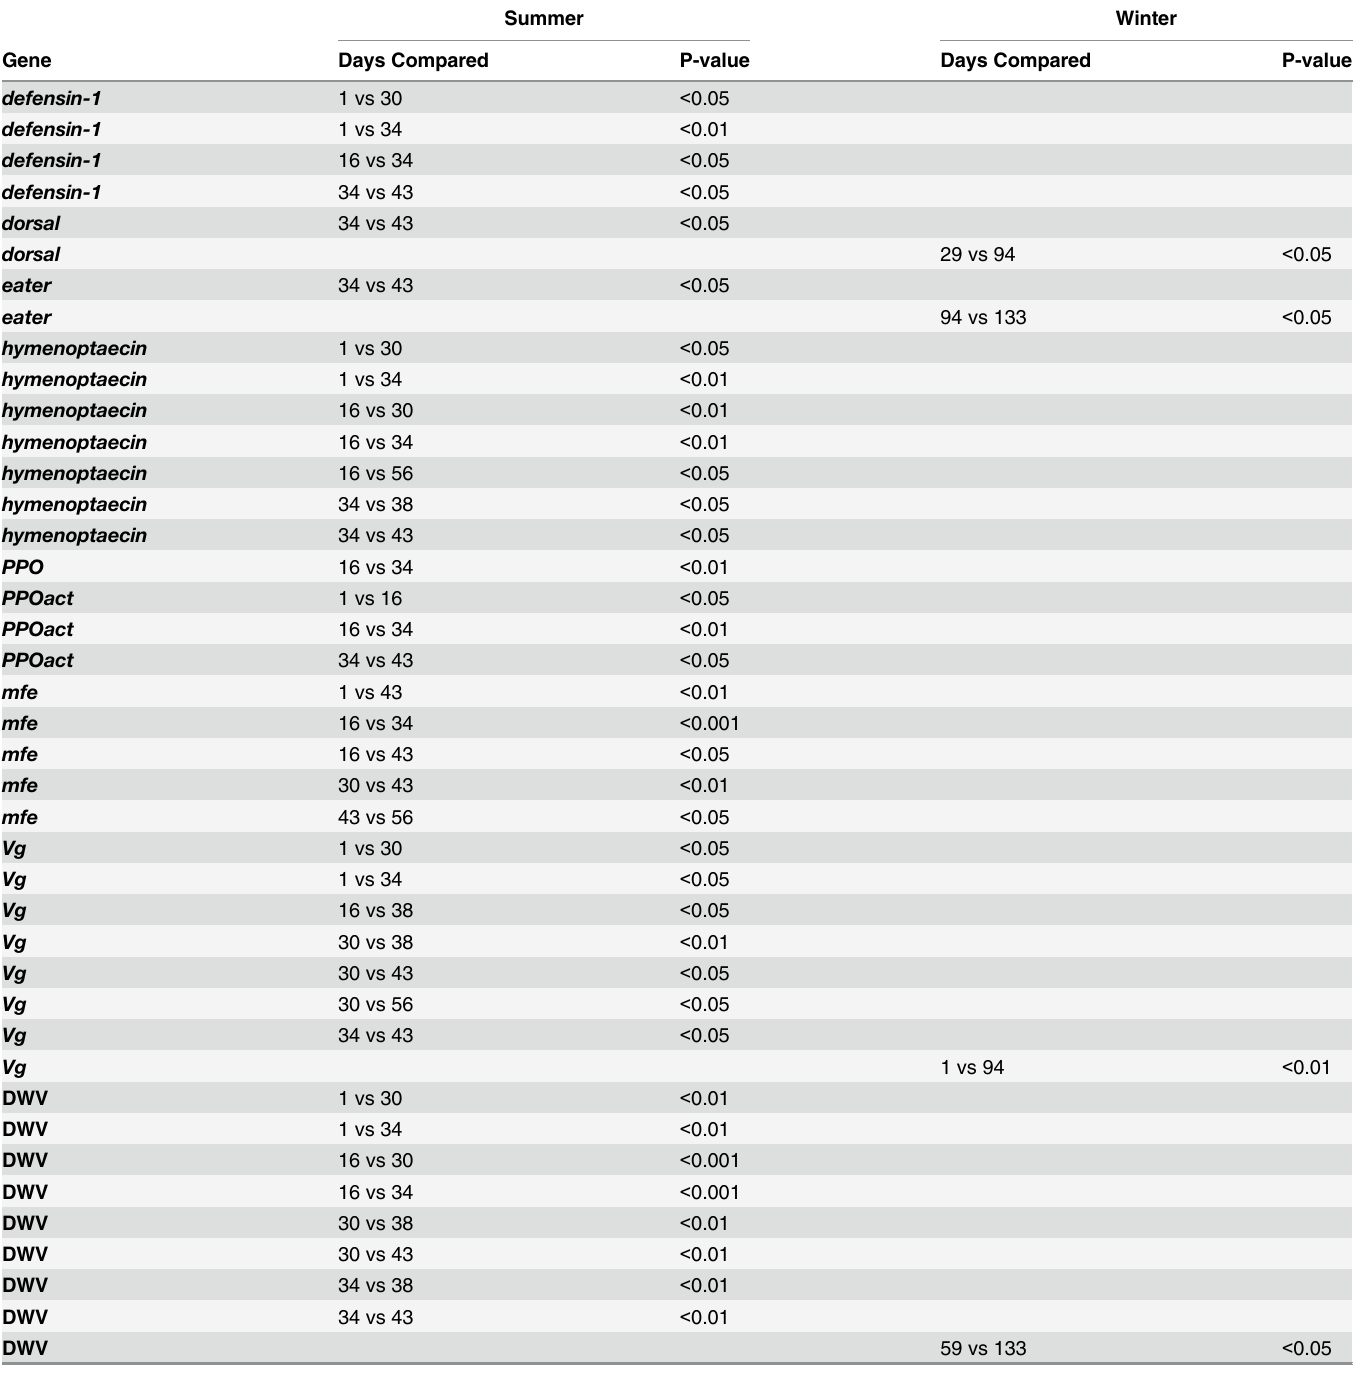
Table 2. Significant variations between single ages in pairwise